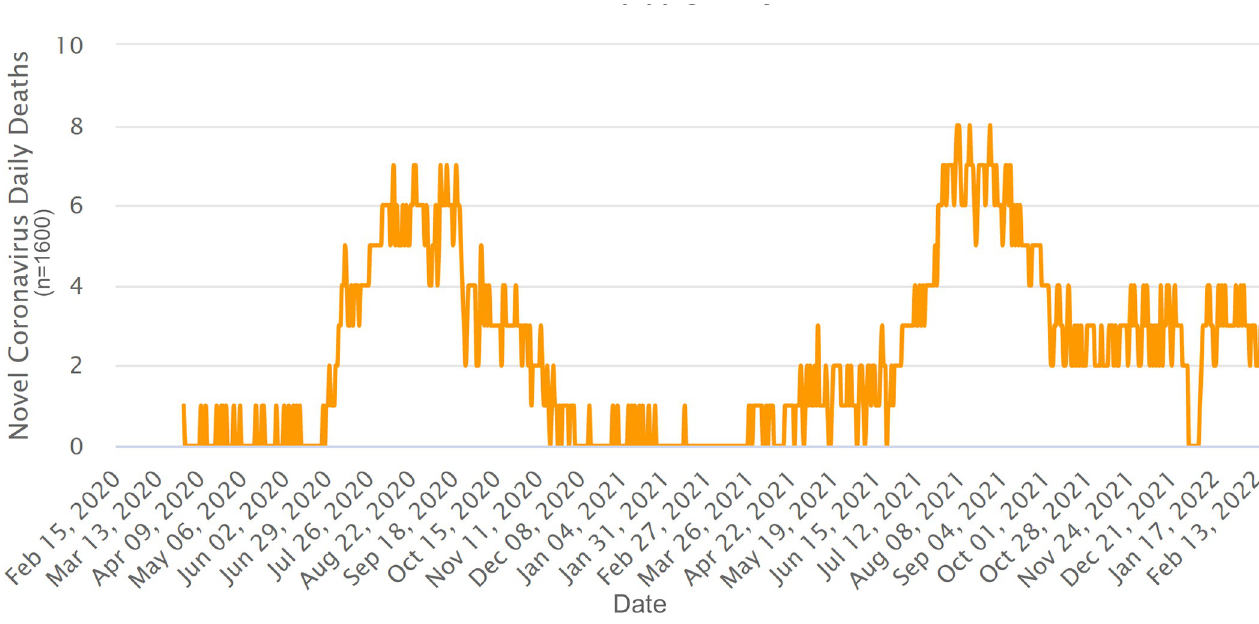
Fig 2. Deaths caused by COVID-19 in Uzbekistan since March 2020 to September 2021 (according to Worldometer, https://www.worldometers.info).